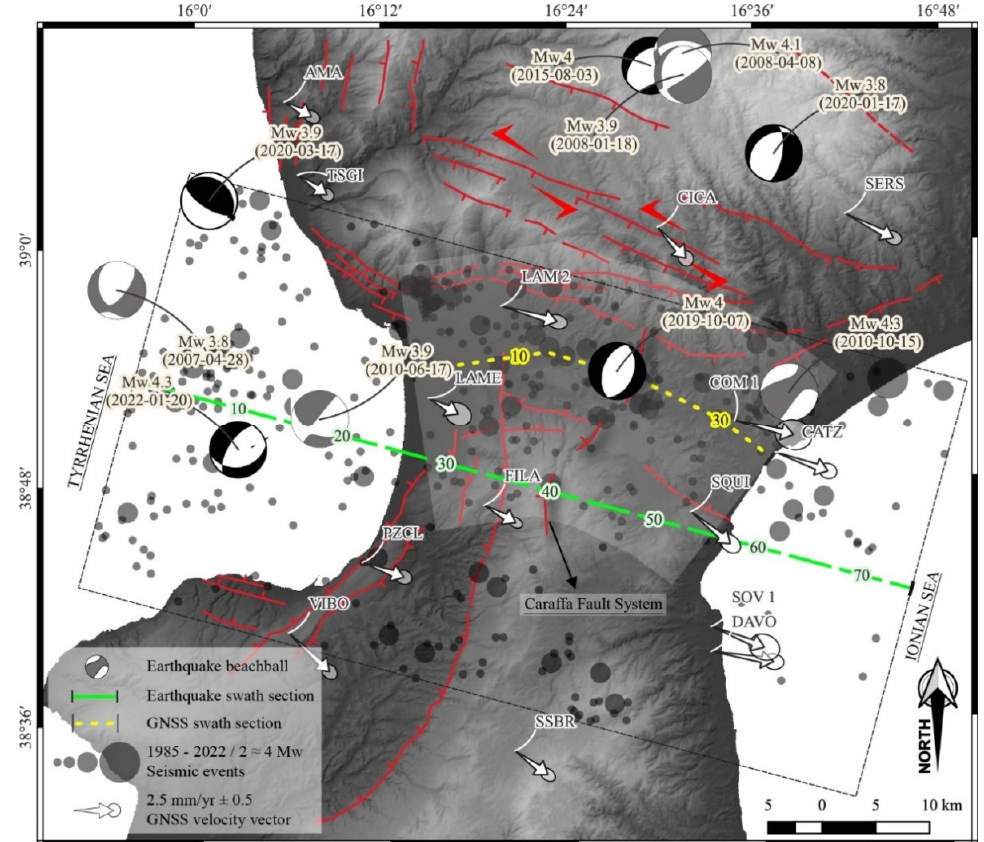
Figure 11. Seismotectonic map of the Catanzaro Trough. The beachballs and grey dots indicate the 1985–2022 instrumental and parametric seismicity (from http://terremoti.ingv.it/, accessed on 15 July 2022; see also [54]). White arrows represent the GNSS velocity field (from Pirrotta et al. [9]). The yellow dashed line and the whitish transparent polygon represent the swath baseline and area, respectively, of the GNSS velocity cross-section, plotted in Figure 12a. The green dashed line and the black dashed rectangle represent the swath baseline and area of the seismicity cross-section plotted in Figure 12b, respectively. The yellow and light green buffered numbers along the two dashed lines represent the distance along the lines expressed in km.